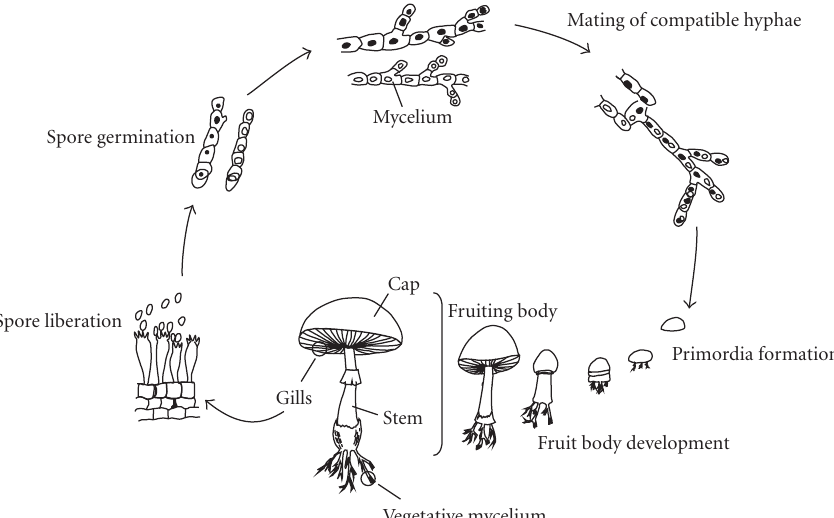
Figure 1. Diagrammatic representation of mushroom life